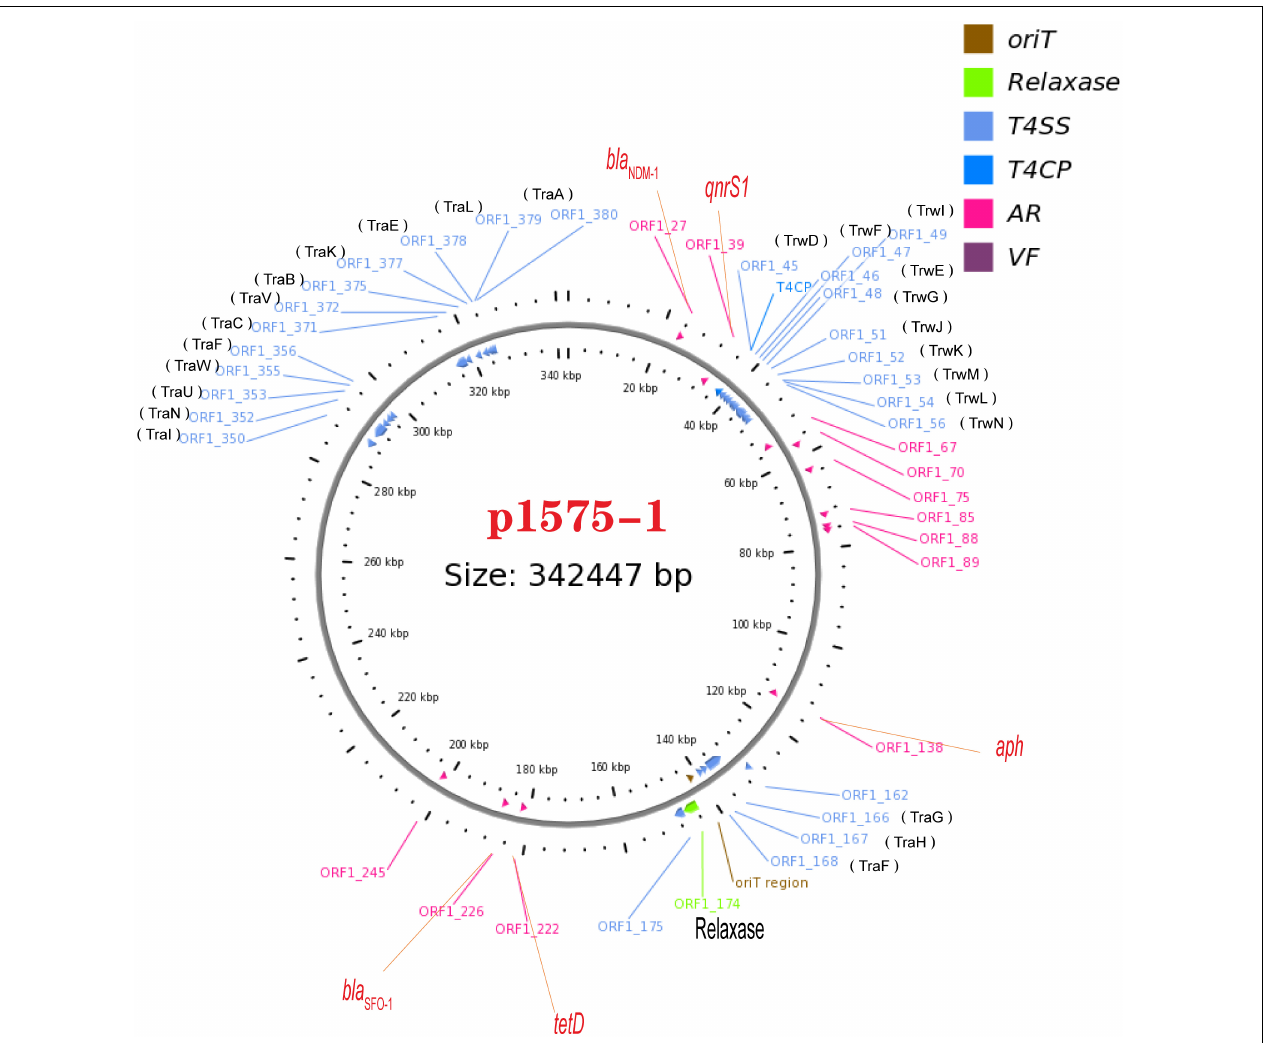
FIGURE 1 | A conjugative plasmid p1575-1. AR (ARGs), acquired antibiotic resistance determinant genes; VF, virulence factors; ORF1-27, bla NDM − 1 ; ORF1-39, qnrS1 ; ORF1-174, Relaxase; ORF1-222, tetD ; ORF1-226, bla SFO − 1